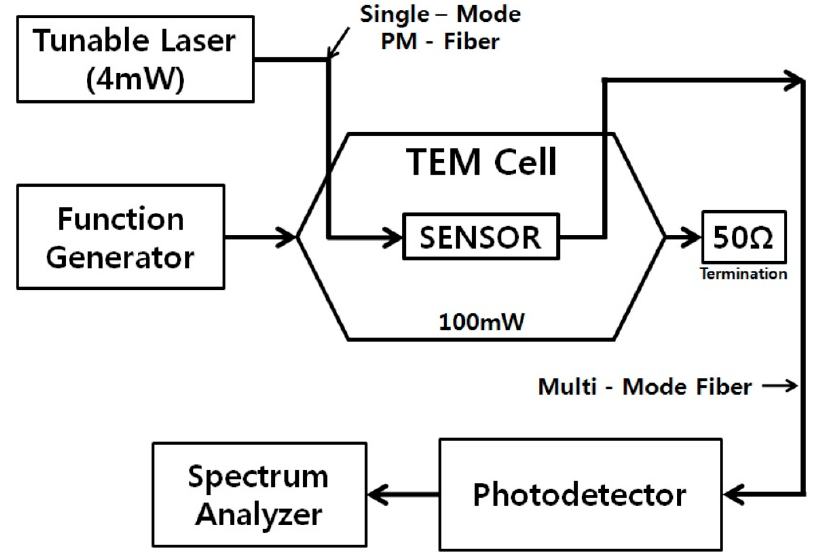
Figure 7. Block diagram of the measurement setup for electric-field sensing and the evaluation of the frequency response. TEM and PM are abbreviations for Transverse Electro Magnetic and polarization maintaining, respectively.